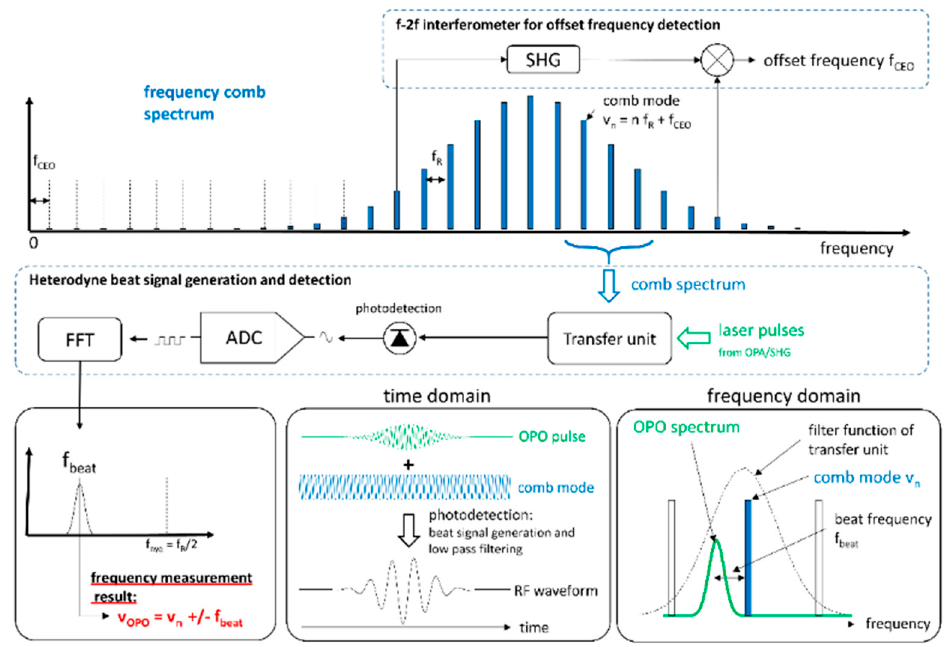
Figure 17. Functional operating principle of the FRUIT.